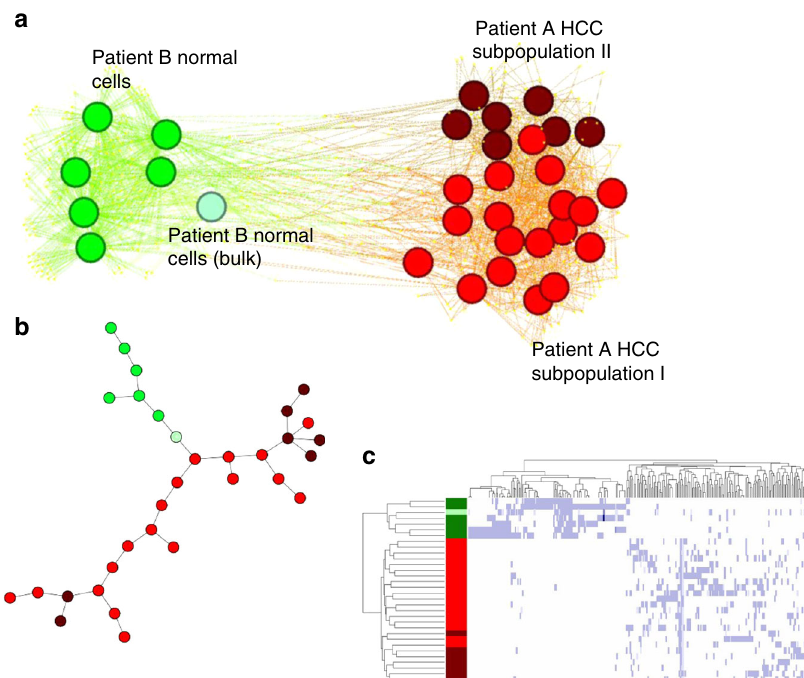
Fig. 7 Heterogeneity revealed by eeSNVs from multi-omics single cell HCC (Hou) dataset. Normal cells are colored green and HCC tumor cells are colored bright (subpopulation I) or dark (subpopulation II) red. a Bipartite-graph representation using the single cells and eeSNVs from RRBS reads as two sets of nodes. b Pseudo-time ordering reconstruction of the HCC cells, using eeSNVs in from RRBS. c Heatmap of the cells (row) and eeSNVs 10X genomic data preprocessing . We downloaded the fastq fi les of two data sets: bone marrow mononuclear cells (BMMC) of 2 individuals and peripheral blood mononuclear cells (PBMC), from the 10X Genomic website (https:// support.10xgenomics.com/single-cell-gene-expression/datasets). We de-